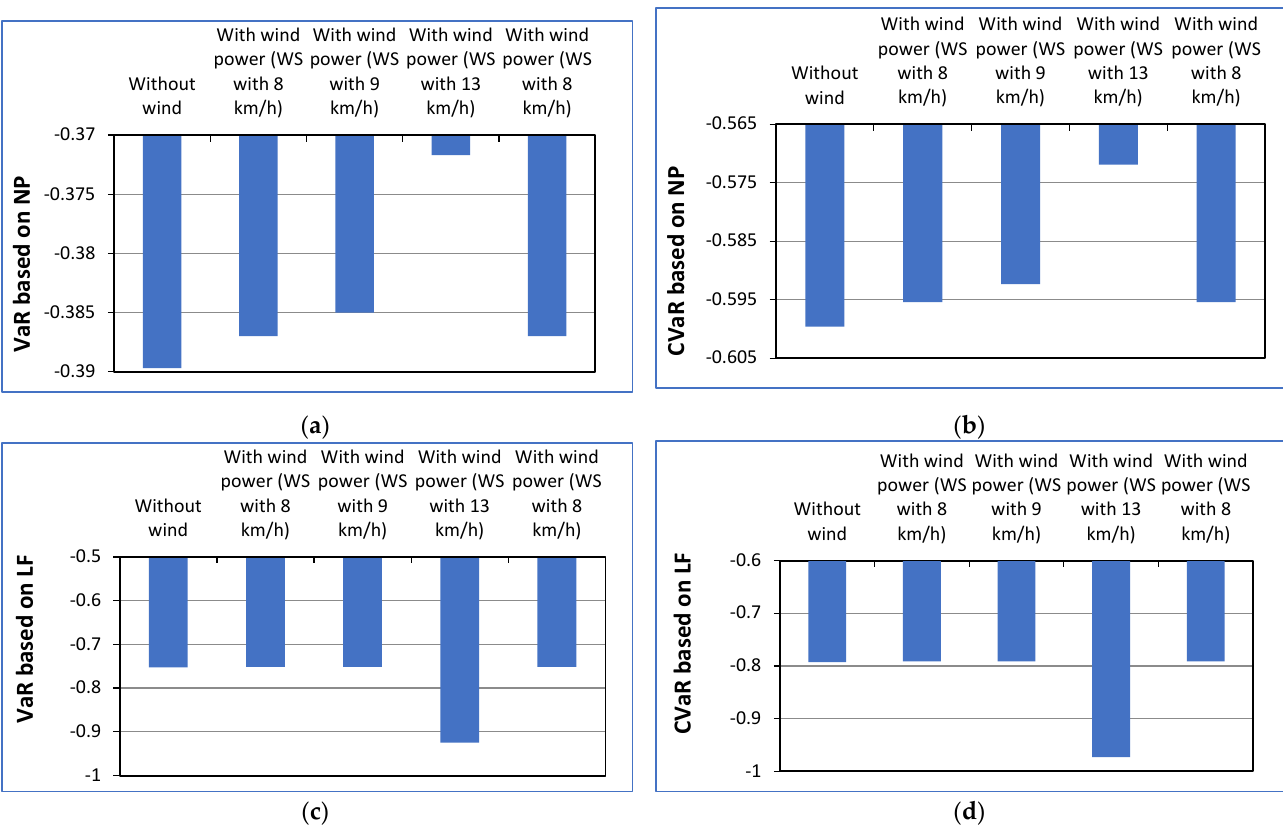
Figure 3. System Risk with Wind Power Integration (Vijayawada @Base Case). VaR based on NP ( a ), CvaR basd on NP ( b ), VaR based on LF ( c ), CvaR based on LF ( d